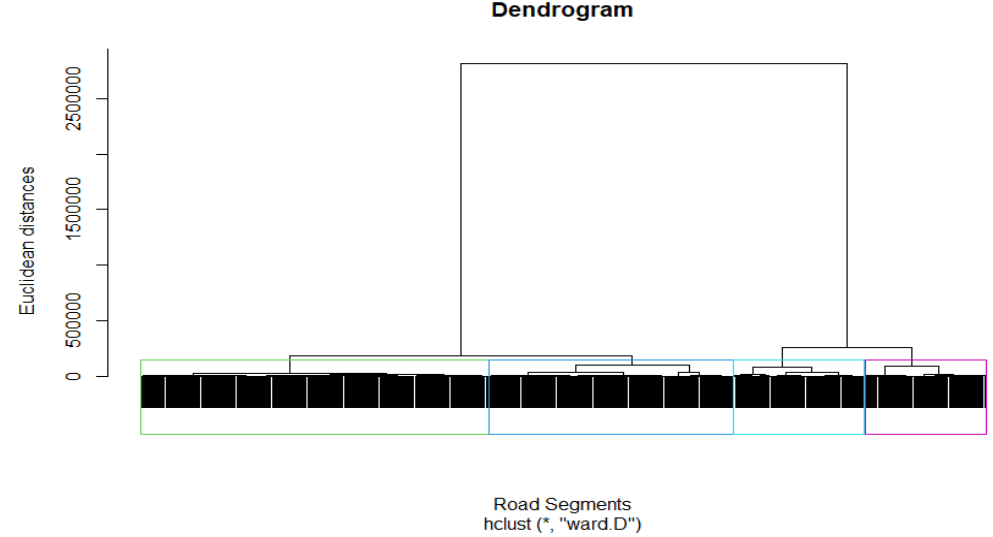
Figure 3. Hierarchical Clustering Dendrogram.